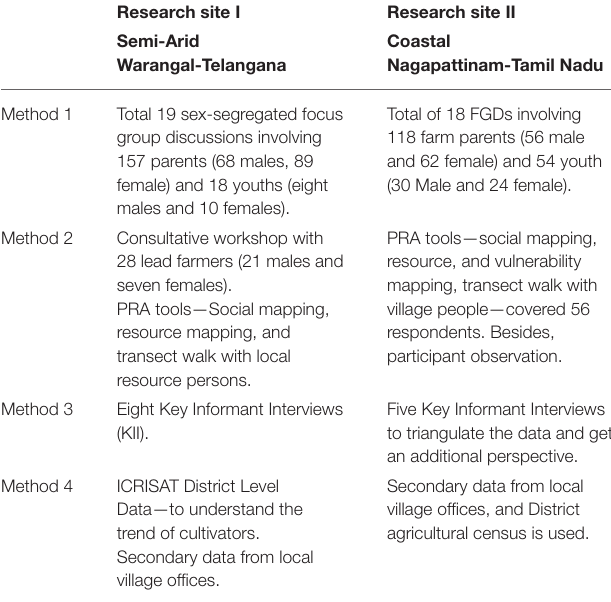
TABLE 2 | Methods used for data